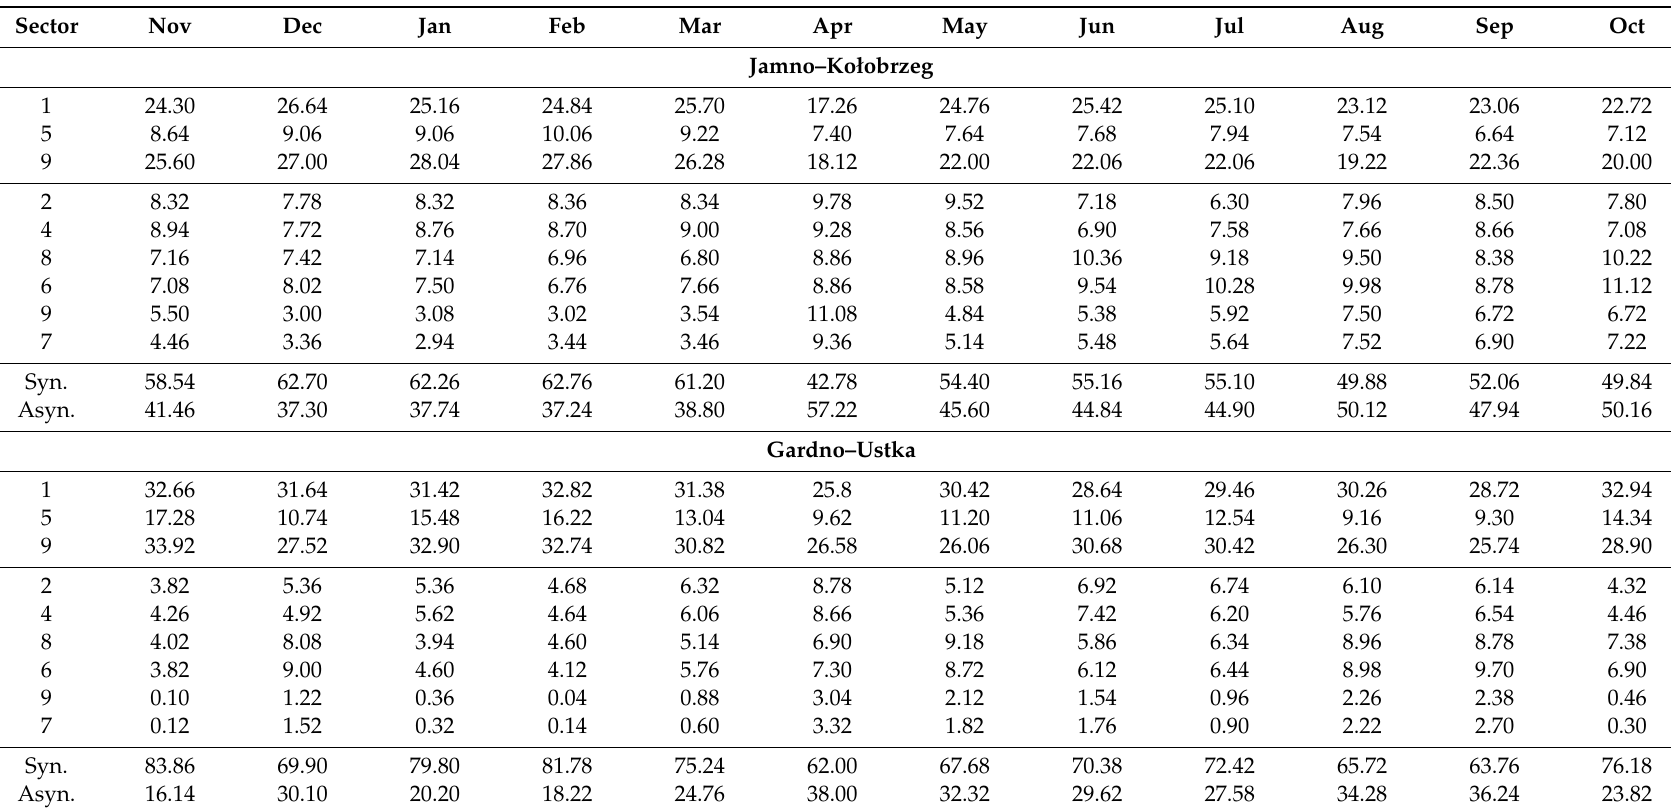
Table 7. Synchronicity and asynchronicity of maximum monthly water levels in Lake Jamno and the sea in Kołobrzeg and Lake Gardno and the sea in Ustka (division into nine sectors) (% share).